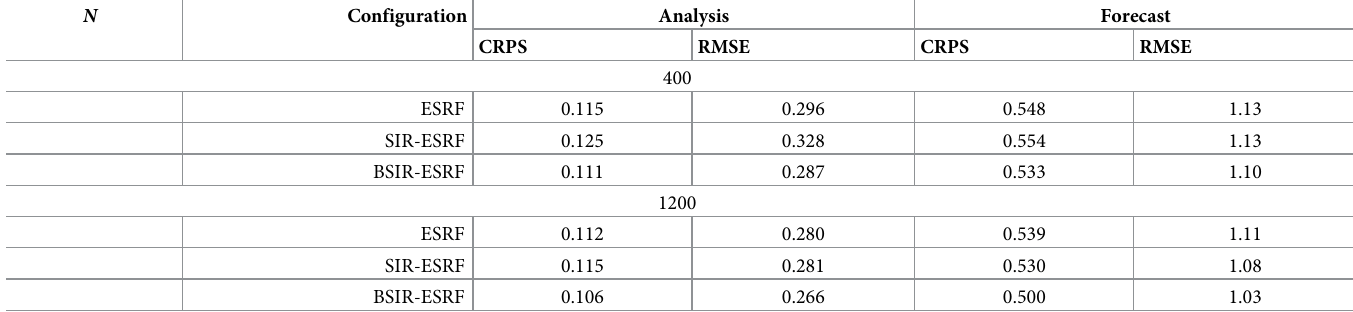
Table 1. Results for optimal parameter configurations of each method: Pure ESRF, hybrid SIR-ESRF, and hybrid with blurred observations BSIR-ESRF. Results are averaged over the last 1400 assimilation cycles and over 8 different sets of initial conditions.